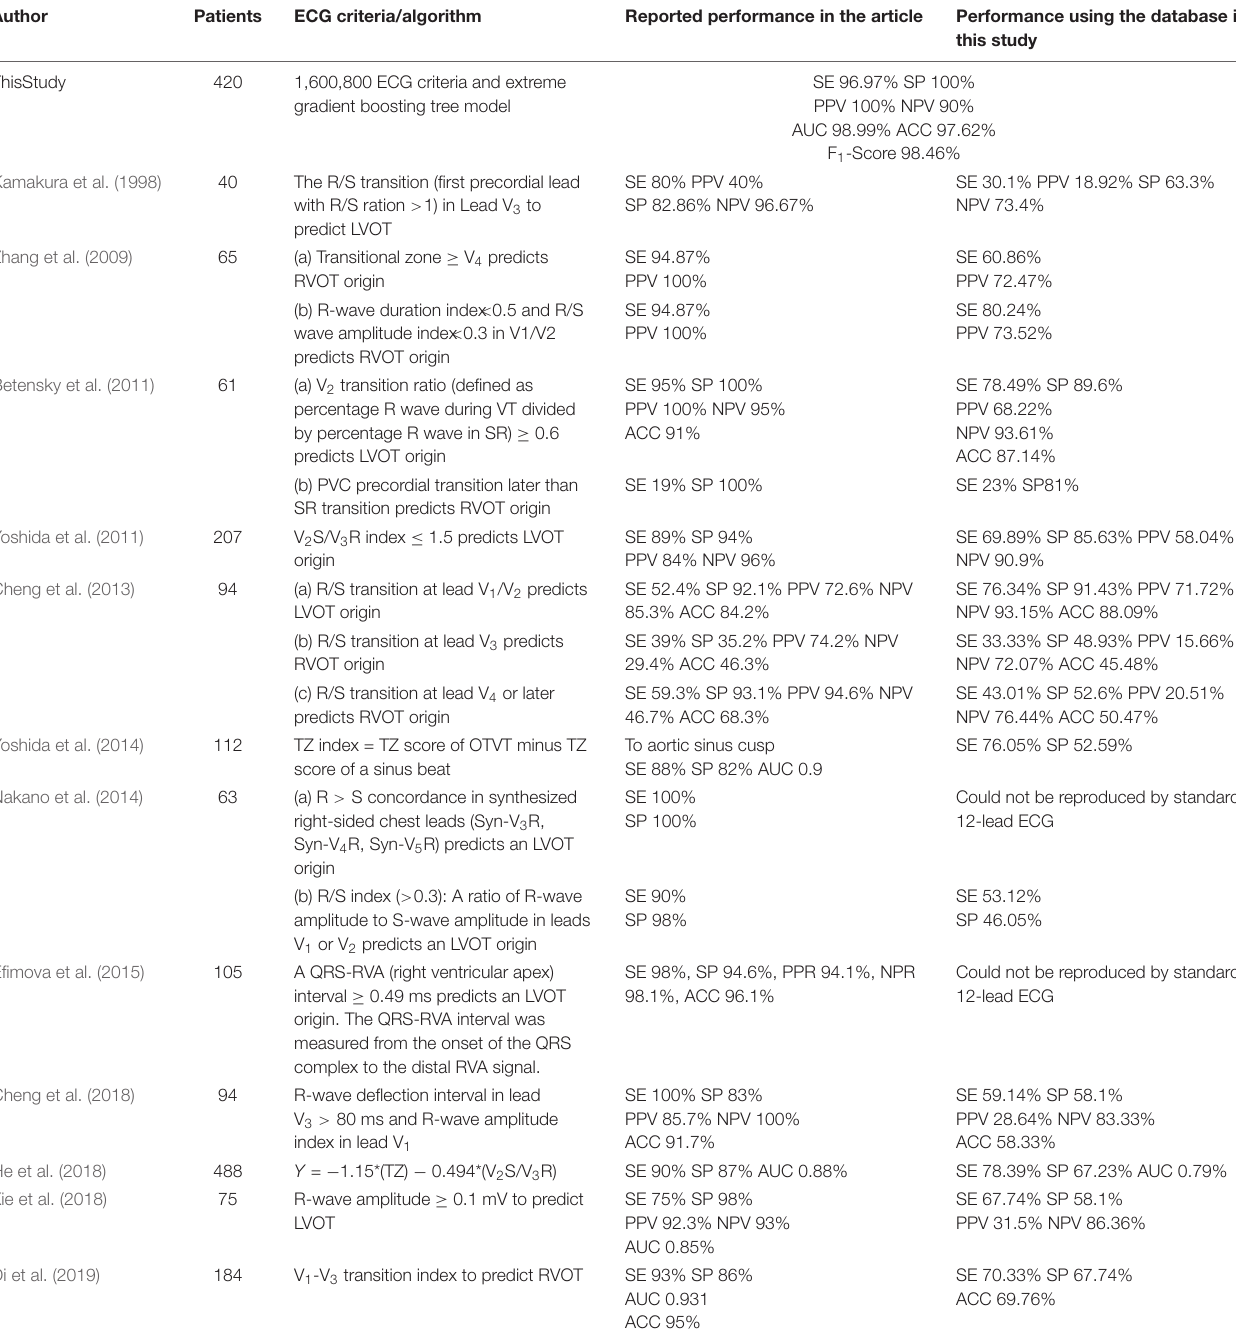
TABLE 3 | Comparison with prior studies to localize the origins of outflow tract